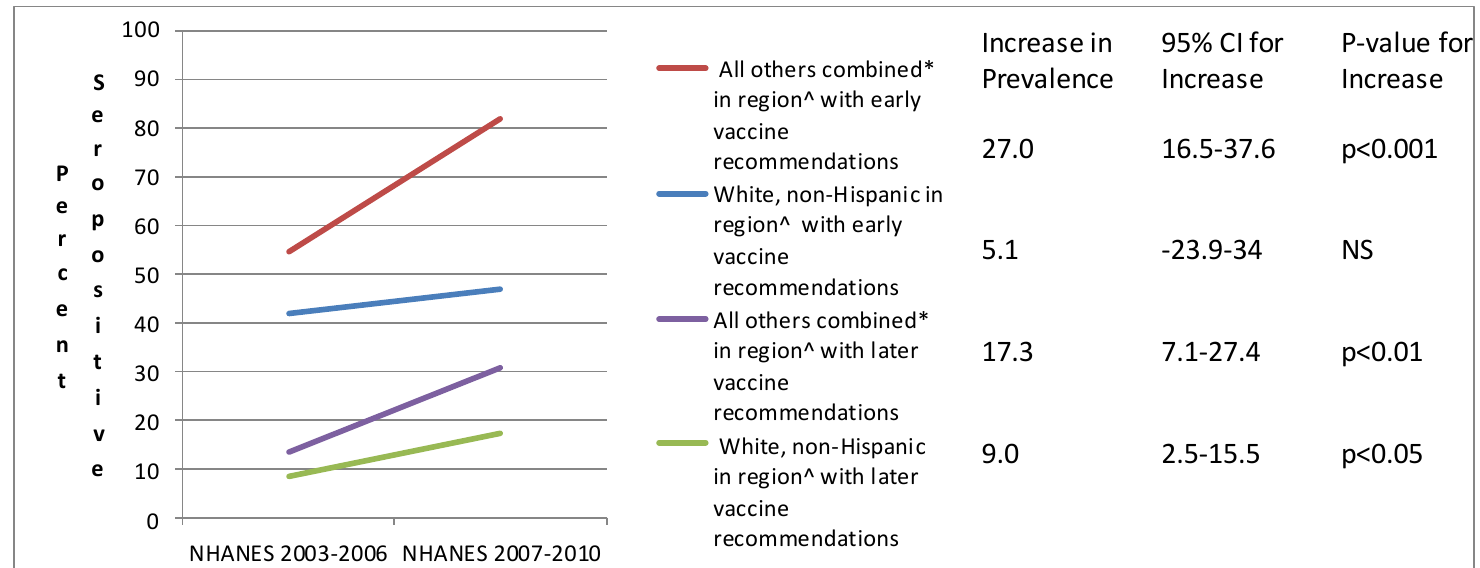
Figure 2. HAV seropositivity over time among U.S. born children and adolescents 6–19 years old stratified by race/ethnic group and region